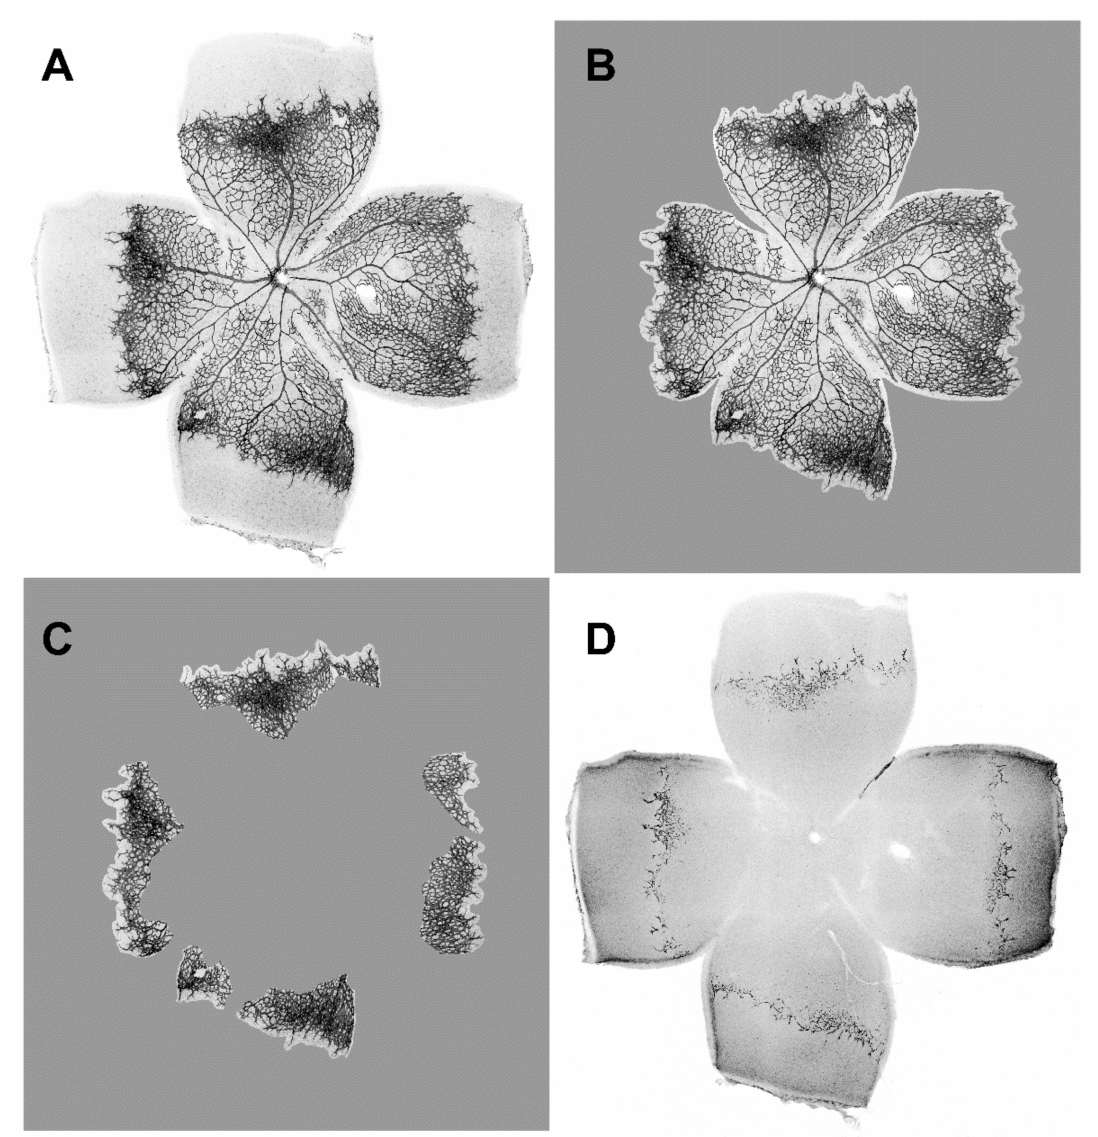
Figure 2. Example for evaluation of a retinal whole-mount. Digital image of a complete retinal whole-mount is shown in ( A ). In this example, size of total retinal area was determined to be 19,752,079 pixels. Size of vascularised area was 13,578,789 pixels ( B ), and size of hypersprouting area 4,607,985 pixels ( C ). According to this, sprouting had a 33.9% share of vascularised area. Staining against the endothelial cell-specific molecule 1 (ESM1) displays the tip cells which helped to determine the hypersprouting areas ( D